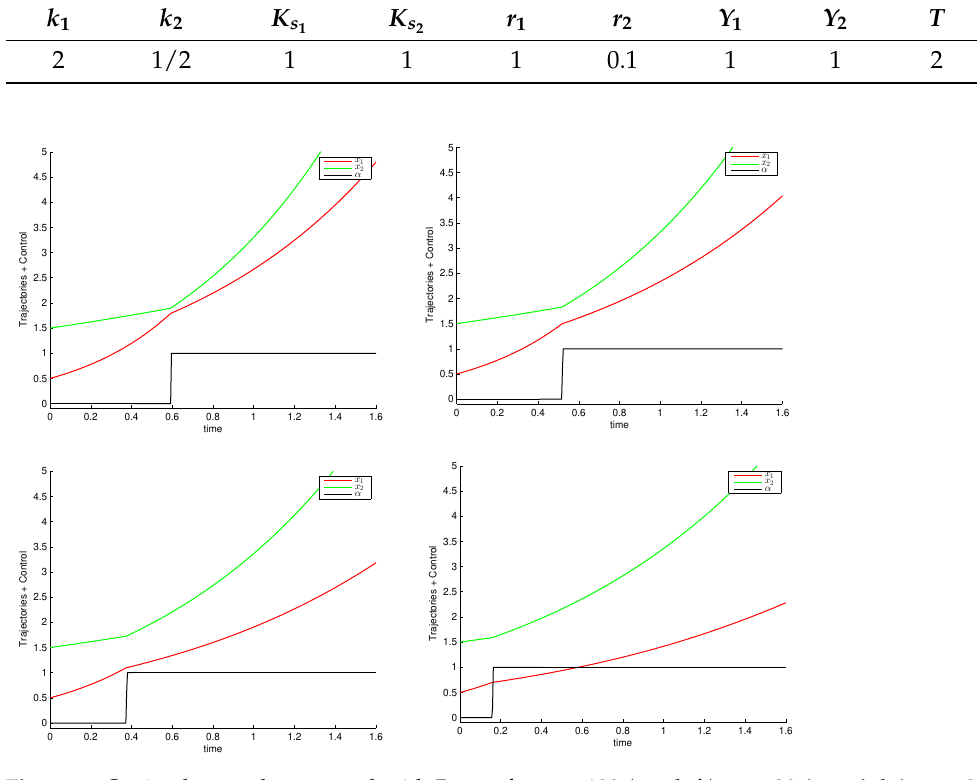
Figure 3. Optimal control computed with Bocop for c = 100 ( top left ), c = 30 ( top right ), c = 20 ( bottom left ), and c = 15 ( bottom right